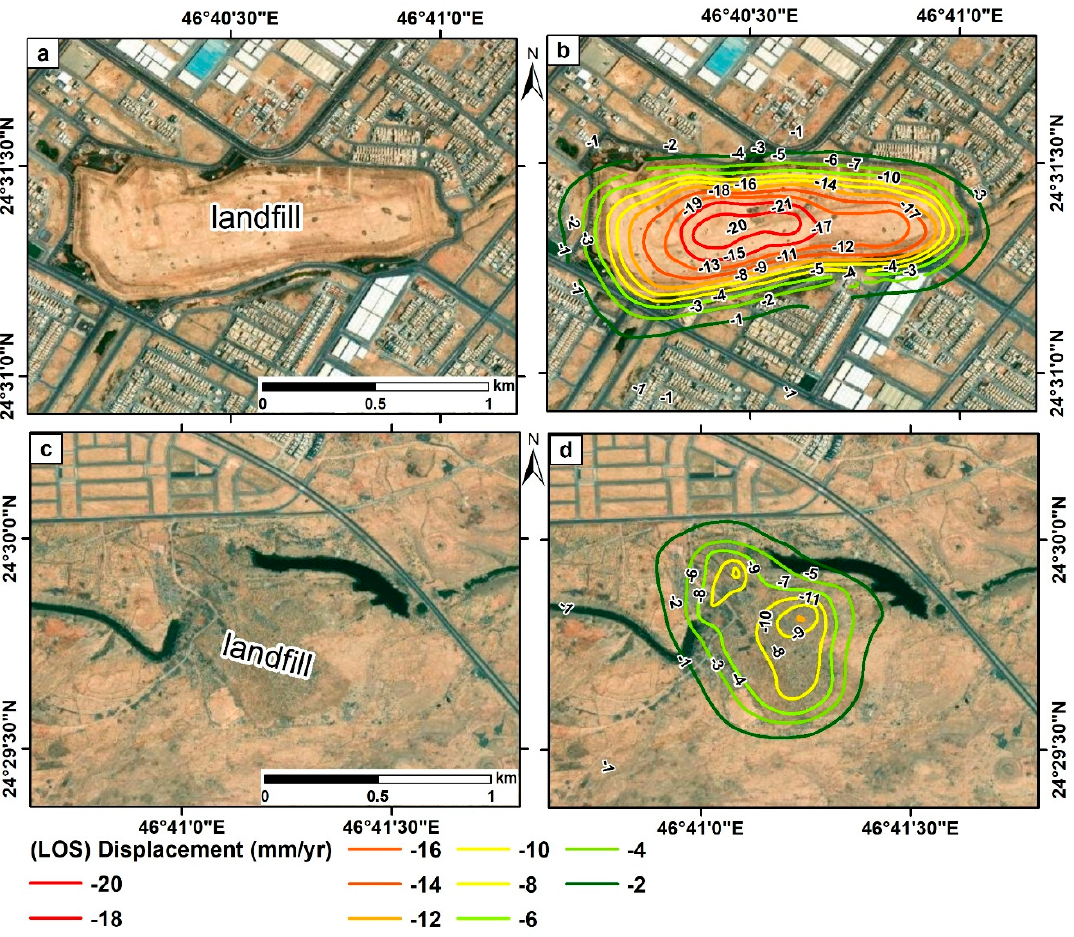
Figure 11. ArcGIS online base map (2019) and LOS velocities over landfill sites (LF1 and LF2) in the Al Marwah District. ( a ) ArcGIS online base map (2019) over site LF1. ( b ) LOS deformation rates plotted over Figure 11a. ( c ) ArcGIS online base map (2019) over site LF2. ( d ) LOS deformation rates plotted over Figure 11c.